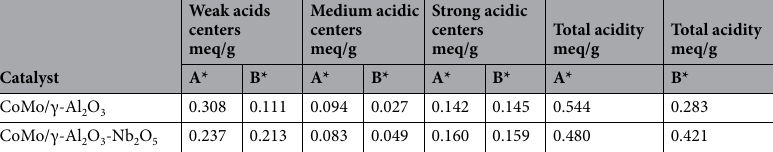
Table 2. Acid strength distribution. *A—samples before sulphidation. *B—samples after sulphidation.